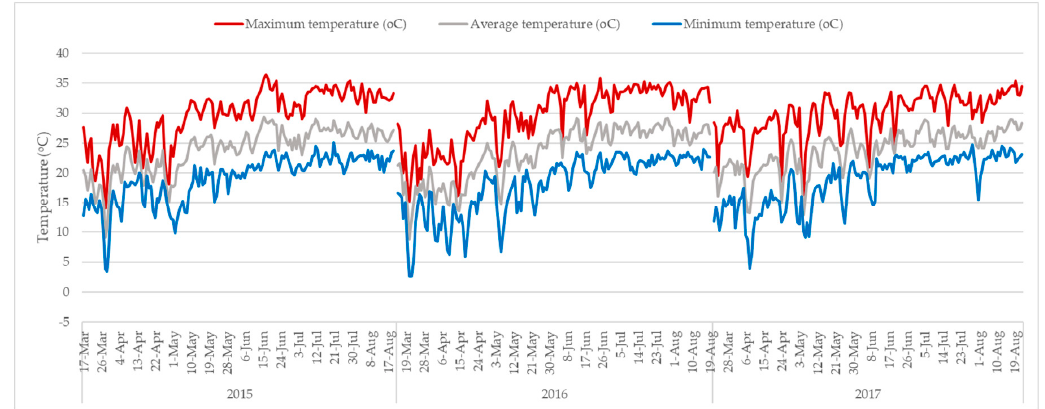
Figure 16. Maximum, minimum, and average temperatures (°C) in the area of Tifton, GA, where the RDC field was located during the maize growing seasons of 2015, 2016, and 2017.